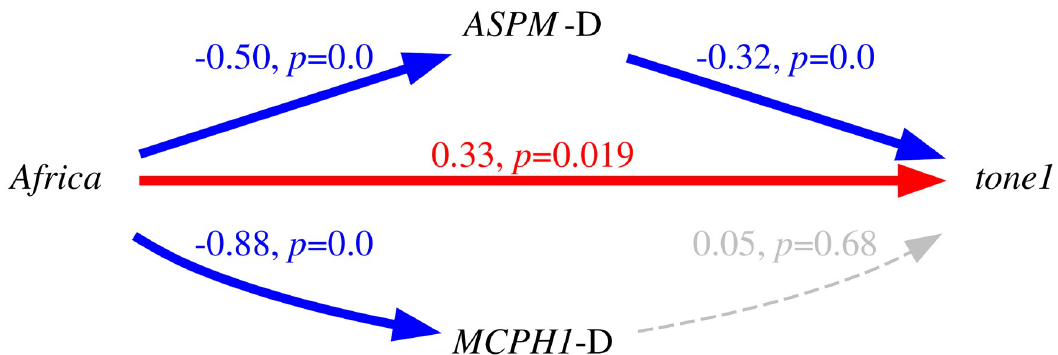
Fig 13. The path model for tone1 (numeric coding) fitted on all the data. Each edge shows the standardized path coefficients and their p -values; gray dotted = not significant, red = significant positive, and blue = significant negative.